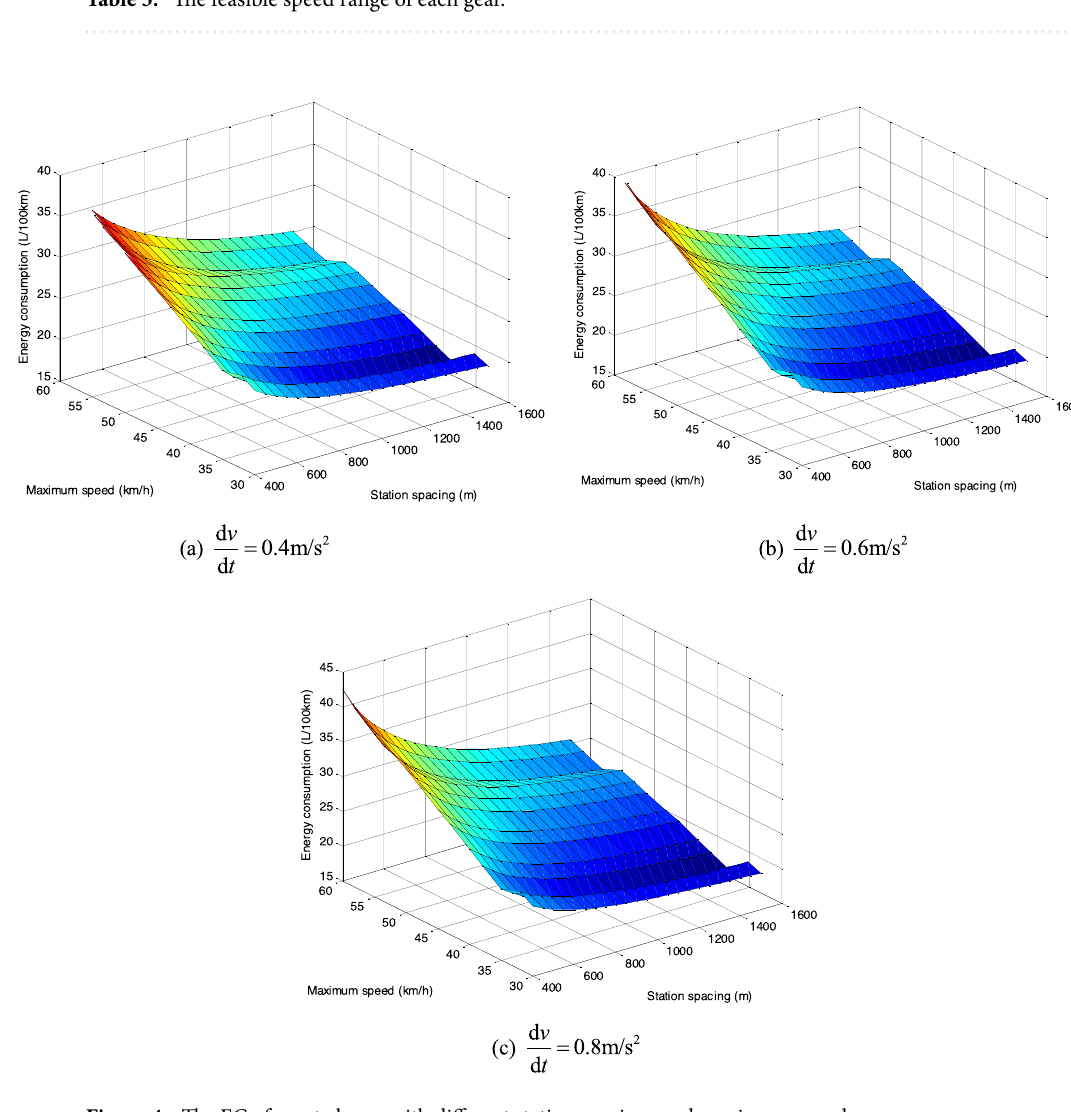
Figure 4. The EC of empty buses with different station spacings and maximum